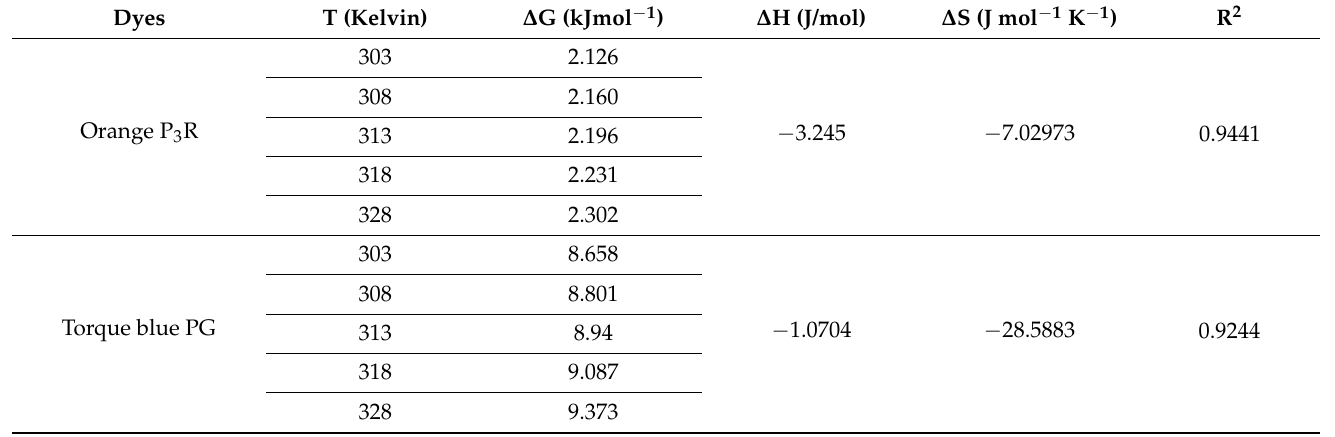
Table 6. Enthalpy change ( ∆ H), Entropy change ( ∆ S), and Gibbs free energy ( ∆ G ◦ ) using calcinized